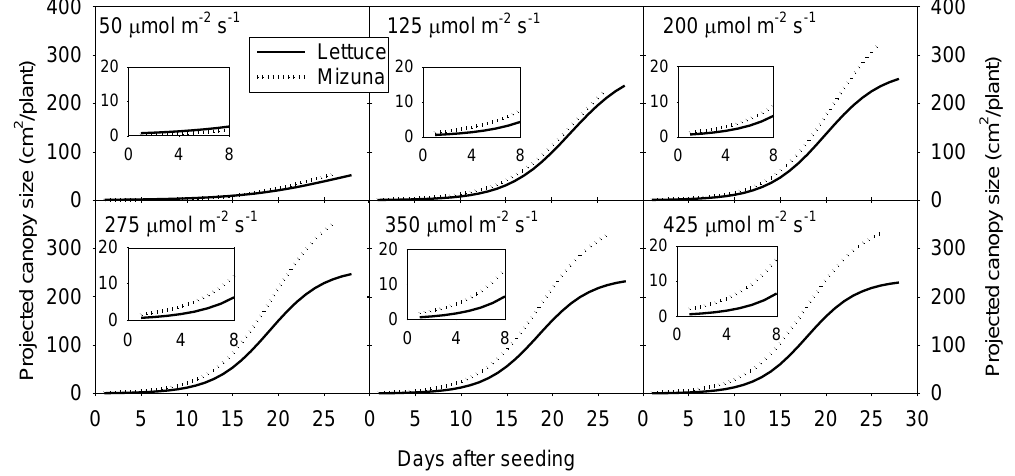
Figure 1. Sigmoidal regression curves fitted through the projected canopy size (PCS) data of mizuna ( Brassica rapa var. japonica ) and lettuce ( Lactuca sativa ‘Green Salad Bowl’) over the course of the growing cycle for plants grown at six different photosynthetic photon flux densities (PPFD, upper left corner of each graph) (R 2 ≥ 0.99 for all curves). Inserts show the PCS during the first eight days of the study.